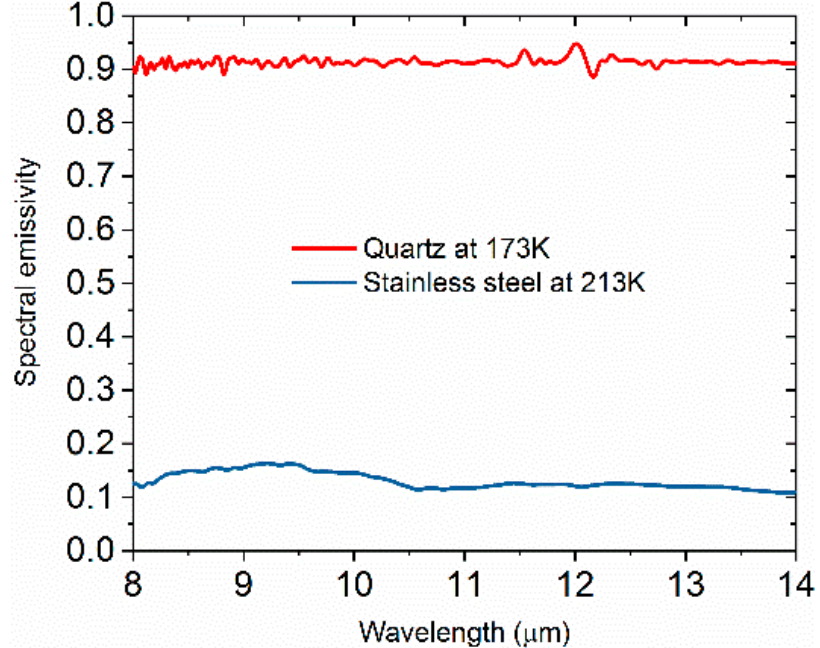
Figure 6. Spectral emissivity of quartz and stainless steel at 173 and 213 K, respectively.